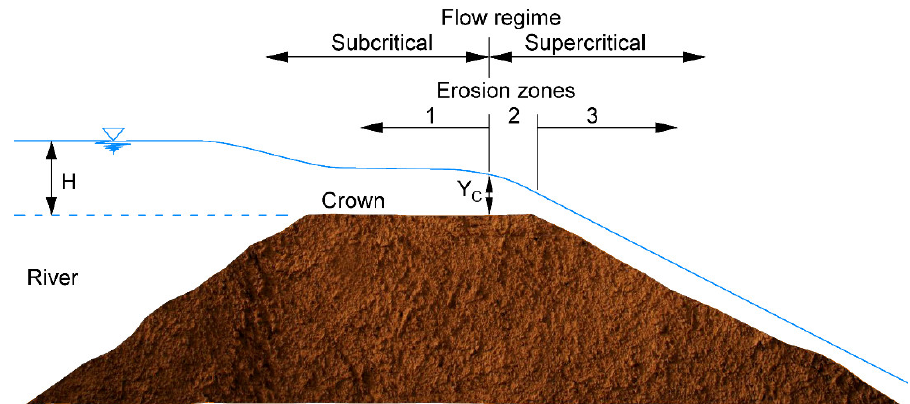
Figure 2. Flowchart of the applied methodology.